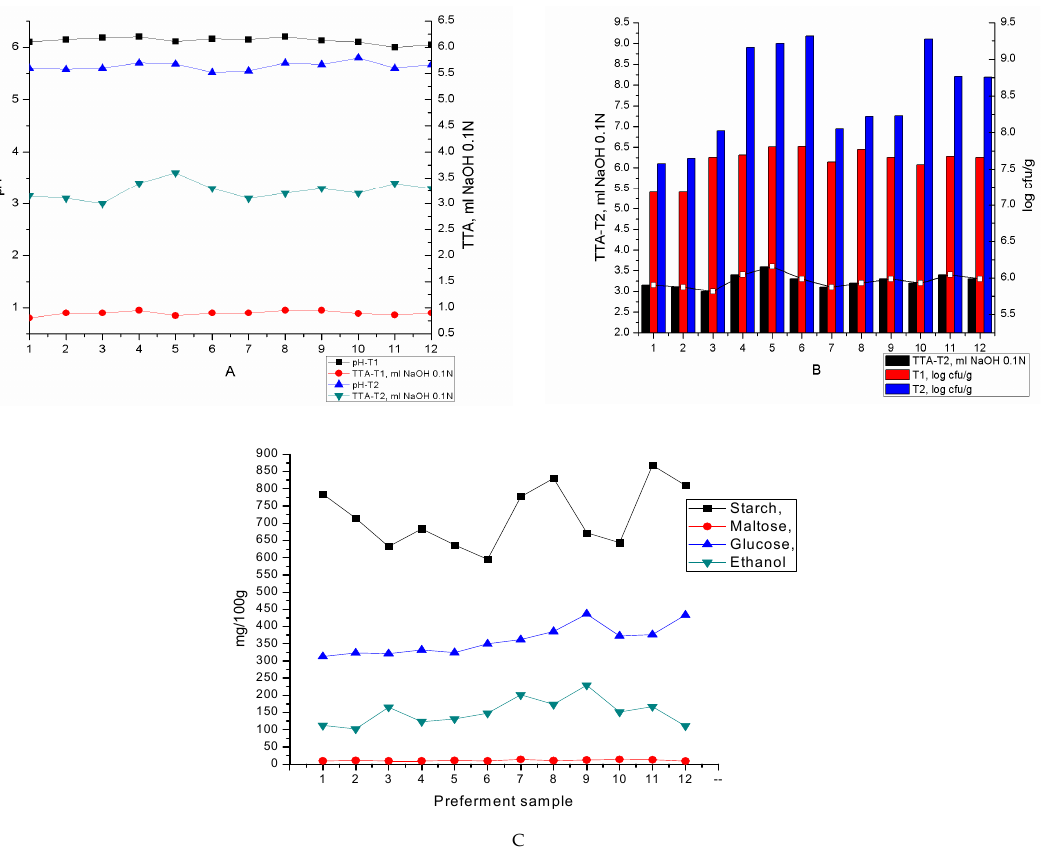
Figure 1. pH and total titratable acidity (TTA,%) variations ( A ), yeast counts ( B ) for preferment samples during fermentation period and carbohydrates conversion and ethanol formation after 18h of fermentation in pseudo-cereals preferment by aromatic yeast strains ( C ) (T1- sampling time before inoculation; T2- sampling time after 18h of fermentation. All determinations were performed in triplicate; For details, see Materials and methods; Each sample code is explained by sample name in Table 1).